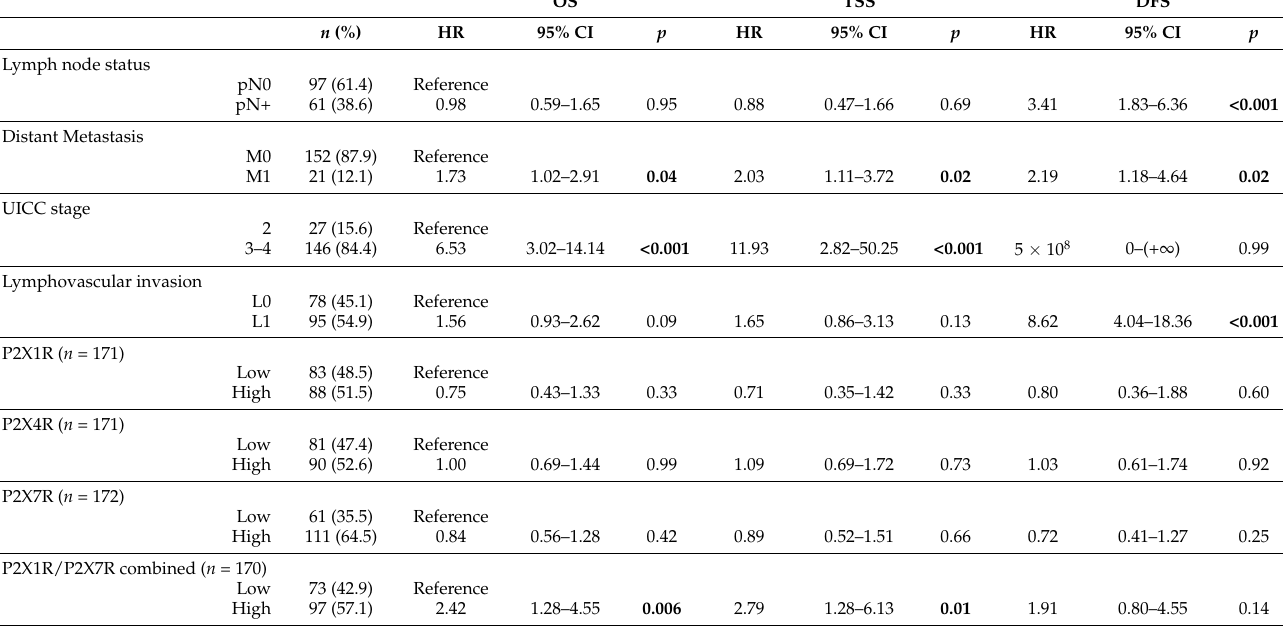
Table 2. Multivariate analysis of potential prognostic survival factors in MIBC